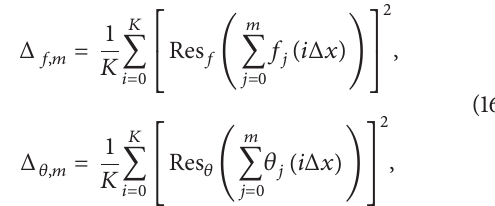
values of Δ 𝑓,𝑚 and Δ 𝜃,𝑚 corresponding to nonlinear algebraic